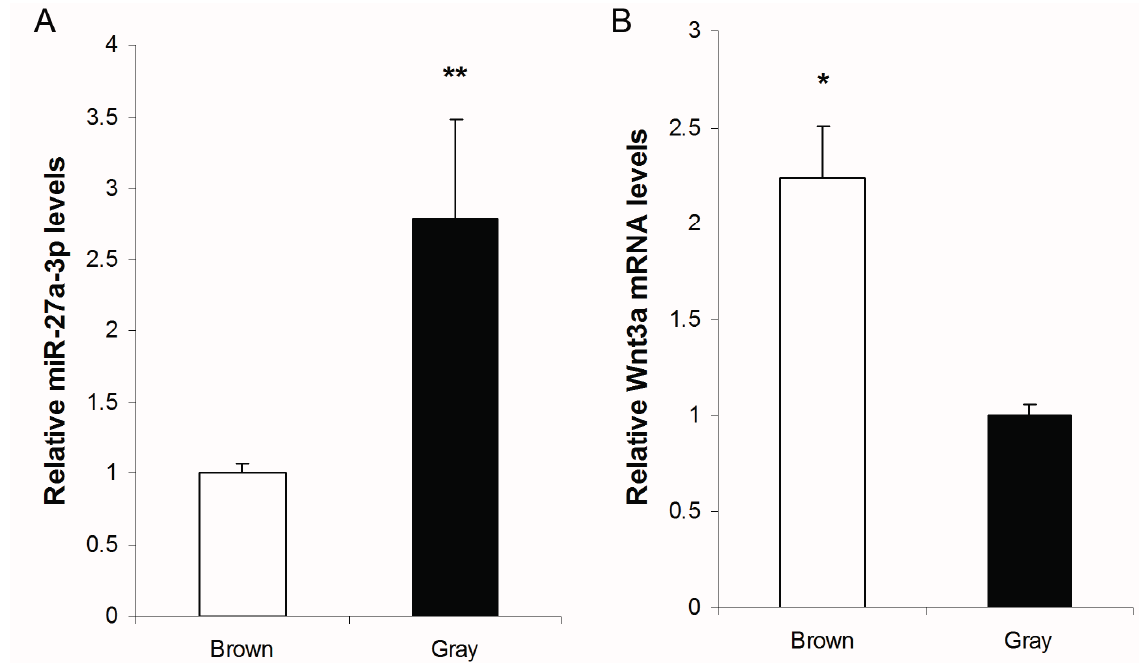
Figure 1. Expression of miR-27a-3p and Wnt3a mRNA in brown and gray mouse skin. ( A ) The relative expression of miR-27a-3p in gray mouse skin is significantly higher than that in brown mouse skin; ( B ) However, the expression of Wnt3a in brown and gray skin shows a contrary trend. Values represent the mean ± SE from four independent experiments. * p < 0.05, ** p <